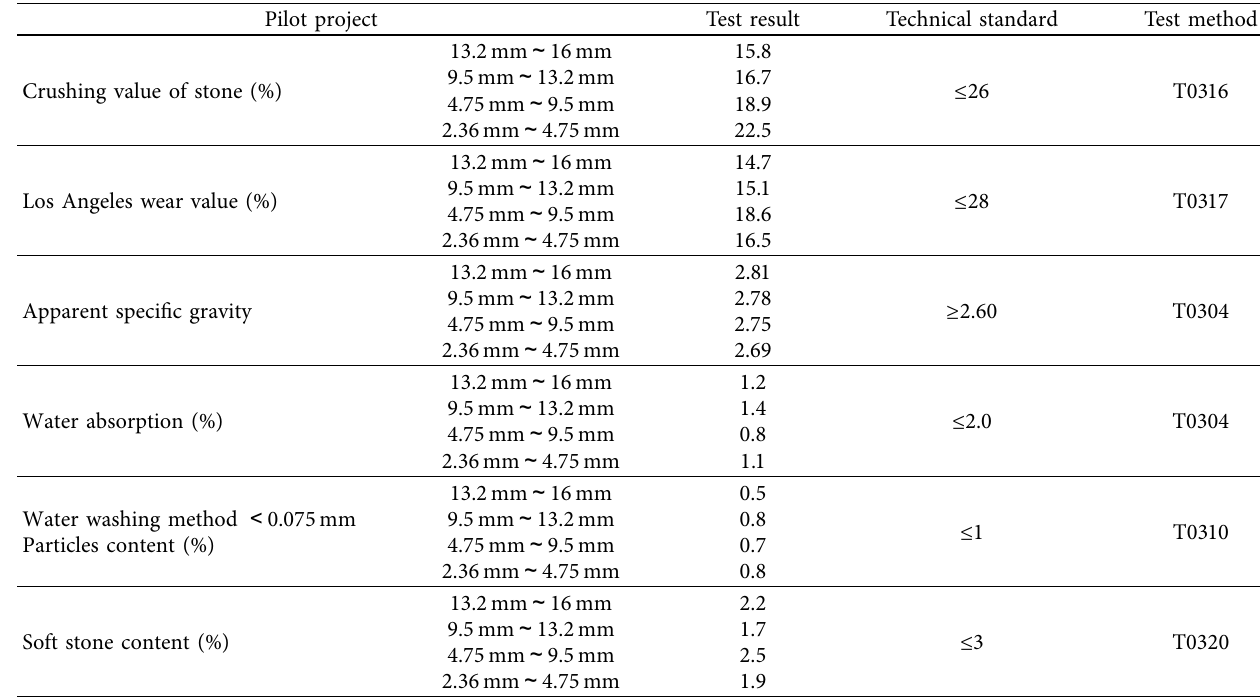
Table 2: Main technical index of coarse aggregate.